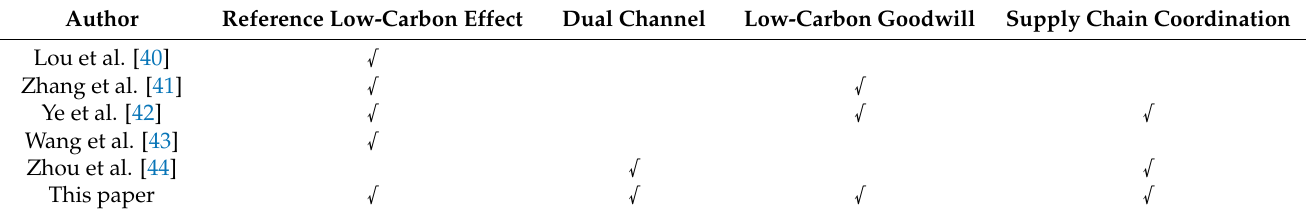
Table 1. Some literature most relevant to this